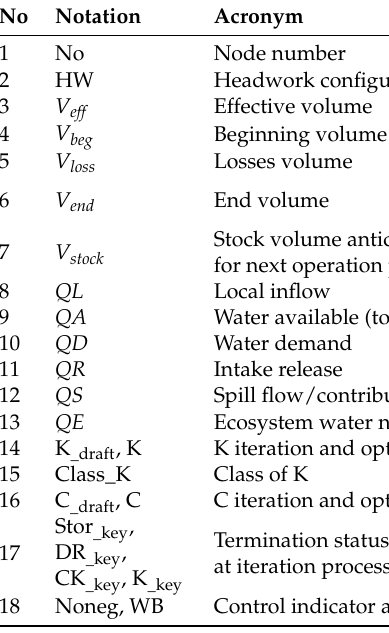
Table 4. Notation in NE